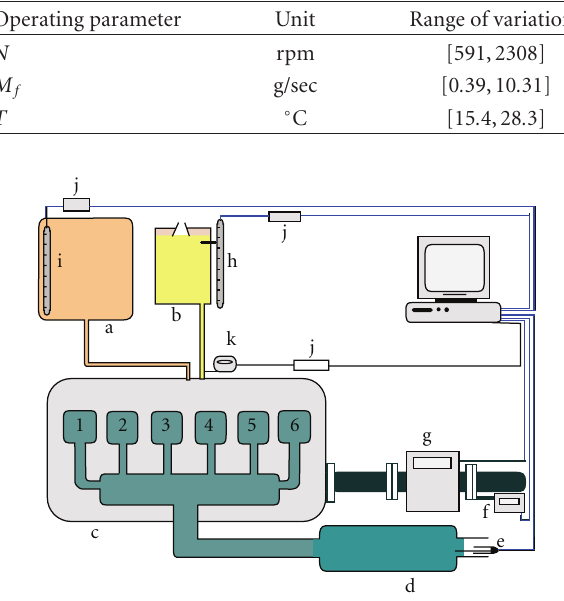
Figure 1: Schematic of the test engine: (a) fuel tank, (b) air tank, (c) test engine, (d) mu ffl er, (e) emissions analyzer, (f) tachometer, (g) dynamometer, (h) air measuring container, (i) fuel